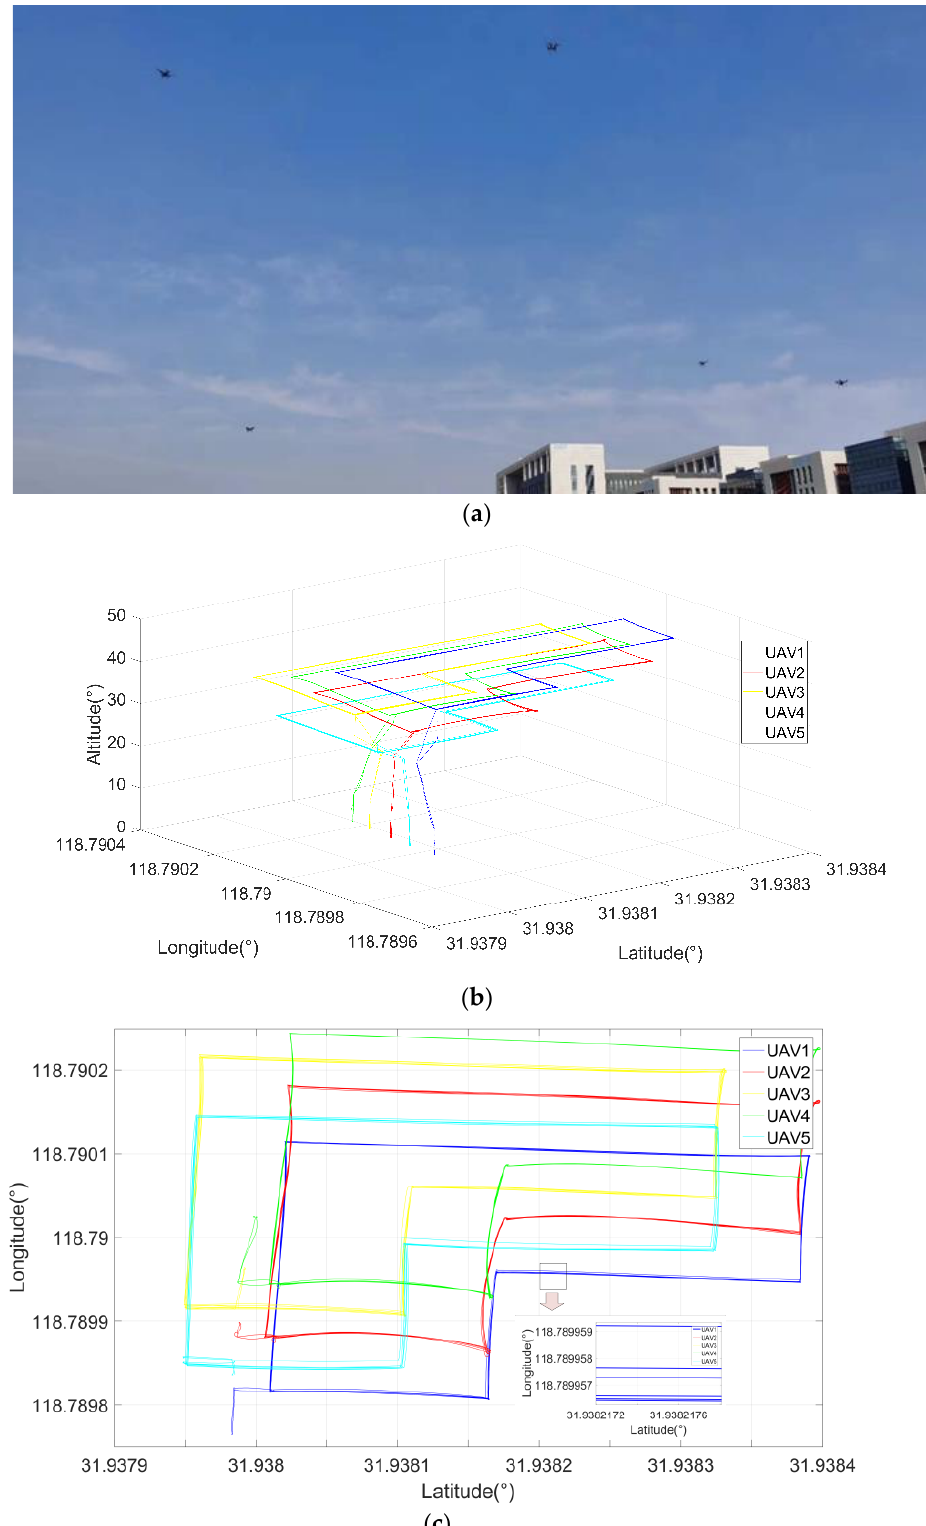
Figure 11. The flight system of UAV swarm.